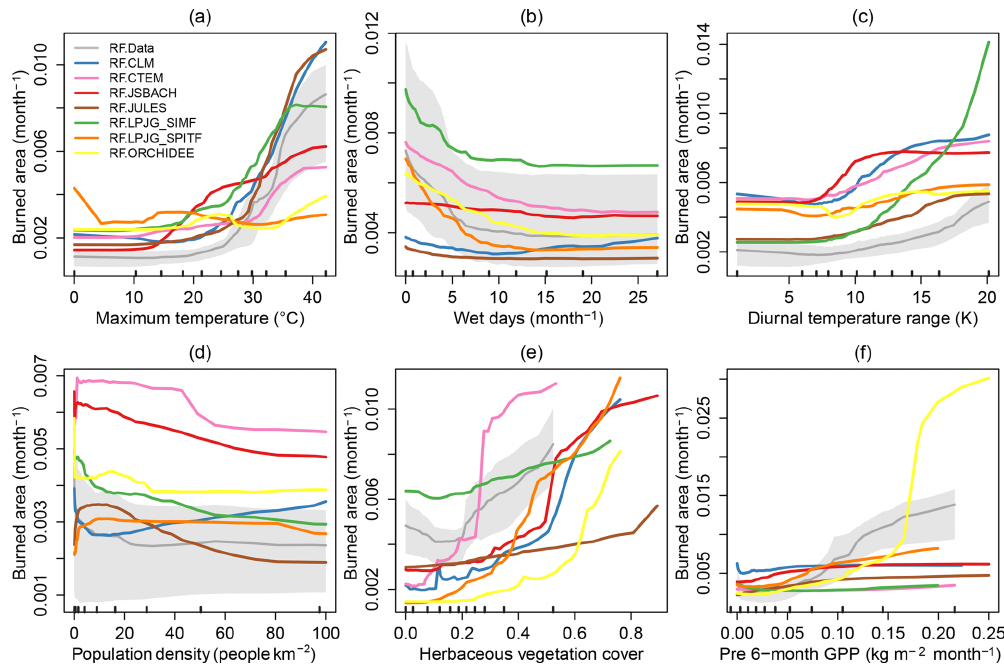
Figure 4. Example of global emergent relationships of the fractional burned area per month to predictors from satellite-derived (grey; mean and range based on the five burned area data sets) and FireMIP model-derived (colours) “fm” random forest experiments for six selected variables. Tick marks along the x axis show the deciles (minimum, quantile 0.1 to maximum) of the global distribution of each predictor variable. Maximum temperature was cut at 0 ◦ C in (a) and population density was cut at 100 peoplekm − 2 in (d) . Emergent relationships for other predictor variables are shown in Figs. S16 and S17.